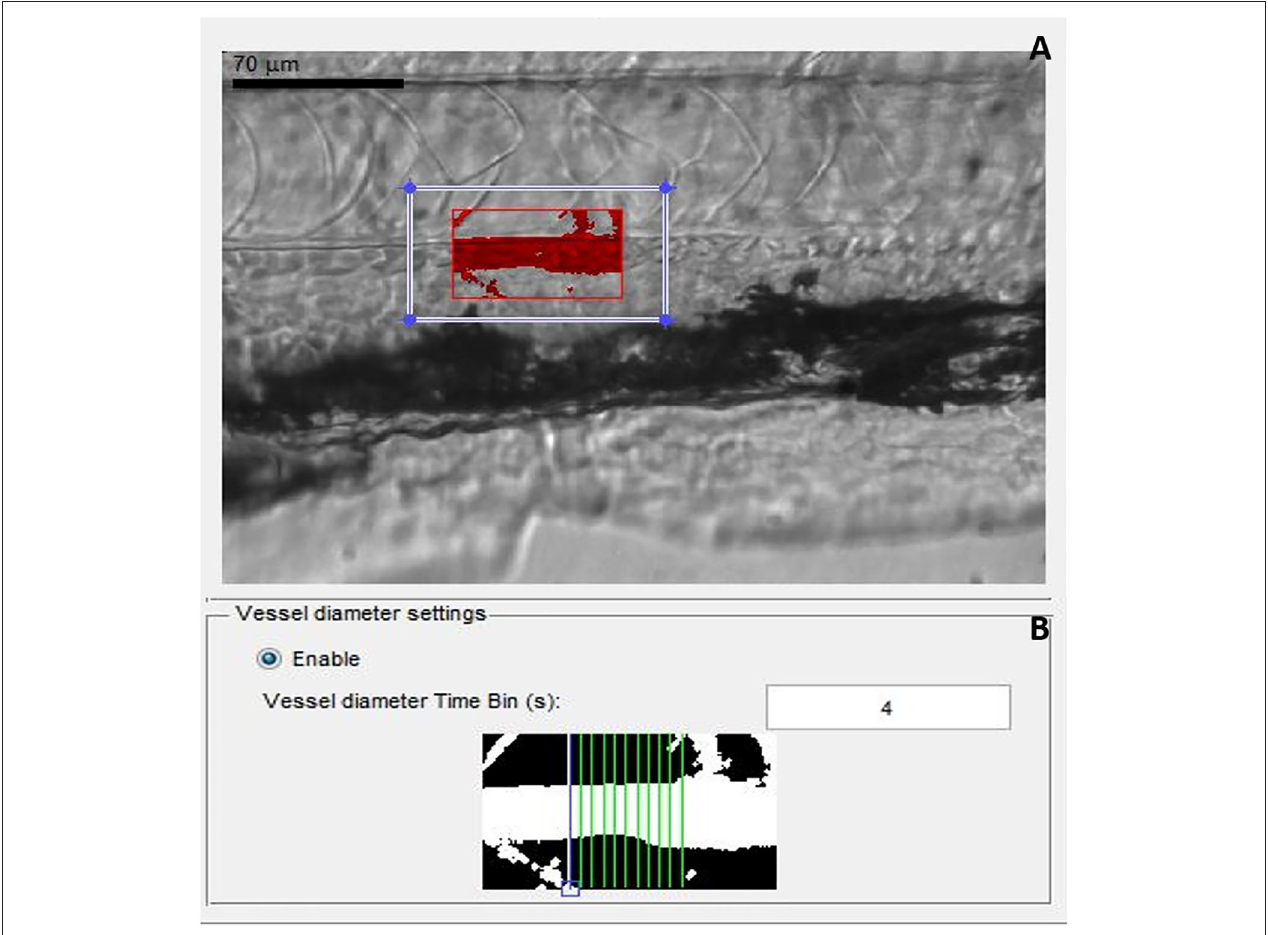
FIGURE 2 | Screen shot images of MicroZebraLab software while recording a video file for analyzing blood flow parameters from zebrafish. (A) Red box represents the area of dorsal aorta selected manually for preparing the video, (B) gray scale image from the software showing measurement of vessel diameter from where the blood flow parameters are